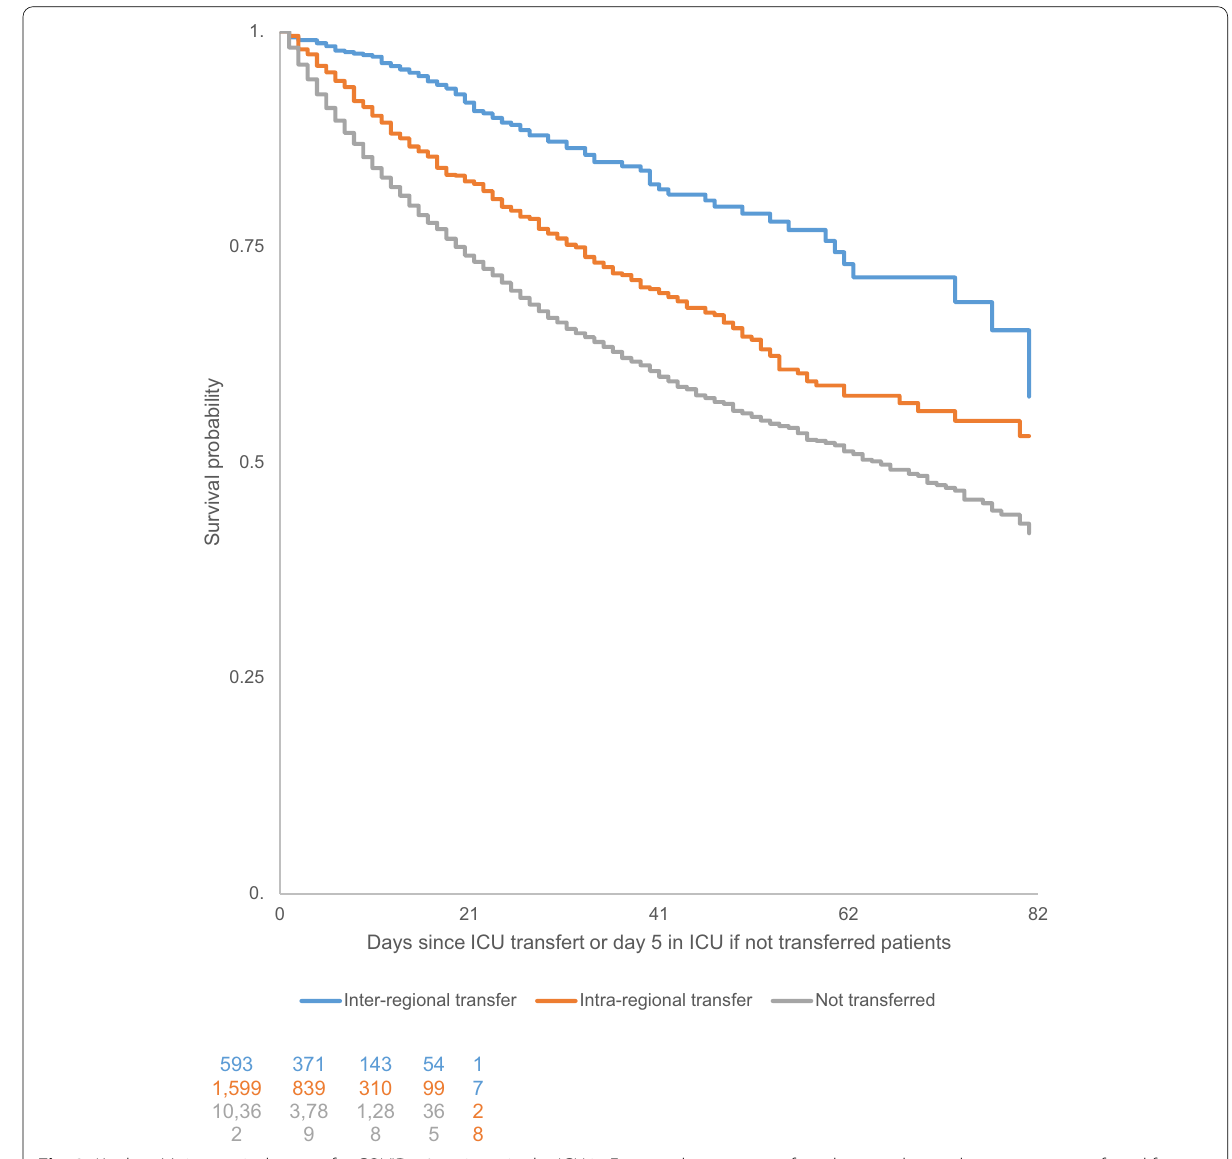
Fig. 3 Kaplan–Meier survival curves for COVID‑19 patients in the ICU in France who were transferred versus those who were not transferred from 1 March to 21 June 2020 among patients hospitalized for 5 days or